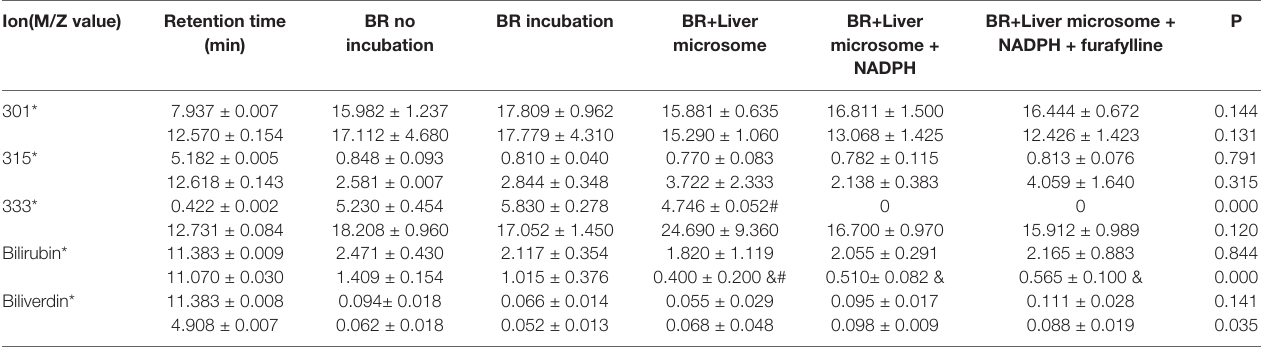
TABLE 3 | Analytical data counts and acquisition time of liver incubation